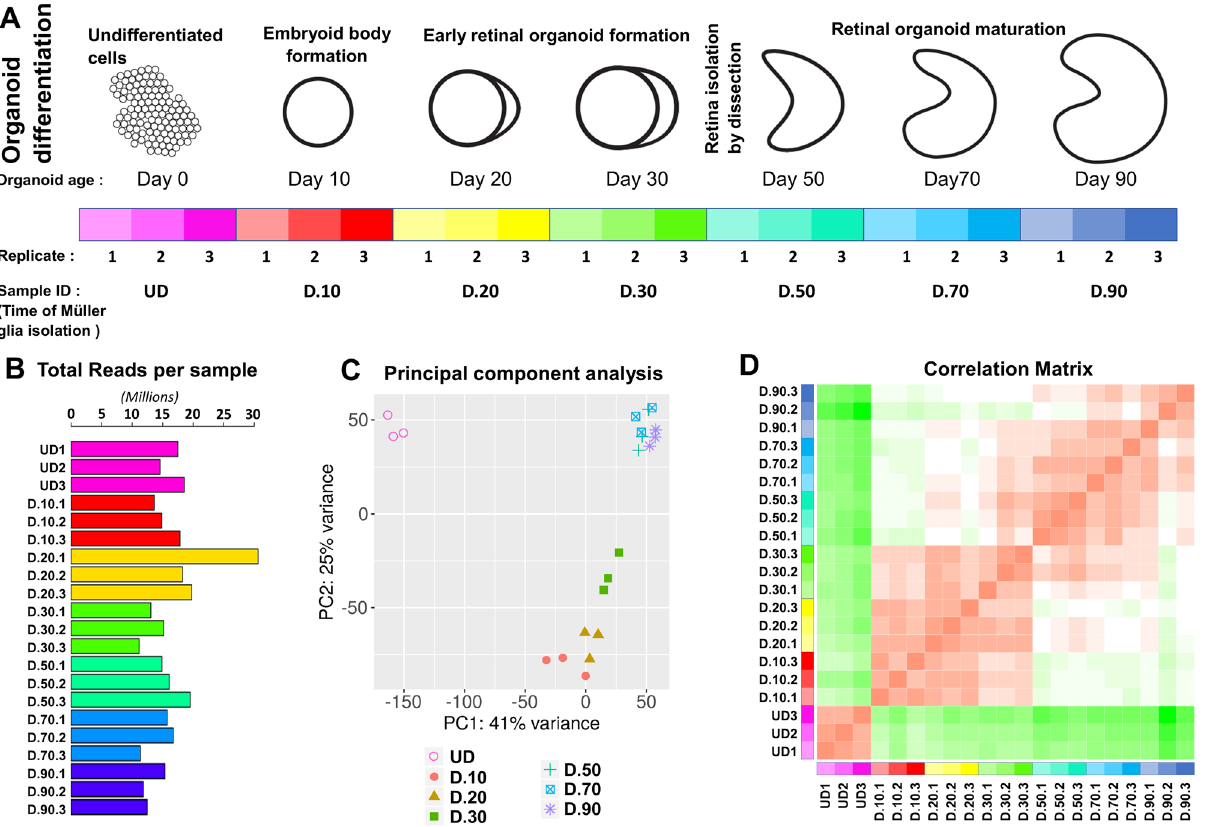
Figure 2. Transcriptomic analysis and overview and RNA seq libraries. ( A ) Schematic drawing shows developmental stages of retinal organoid development, and description of cells collected from each stage of development. ( B ) Bar graph shows the total number of reads obtain from each sample ( C ) principal component plot shows the clustering of each transcriptome group, including undifferentiated stem cells (UD) and Müller glia isolated from retinal organoids at days 10, 20, 30, 50, 70 and 90 after initiation of differentiation. ( D ) Matrix shows the RNA-seq correlation between samples as determined by Pearson correlation